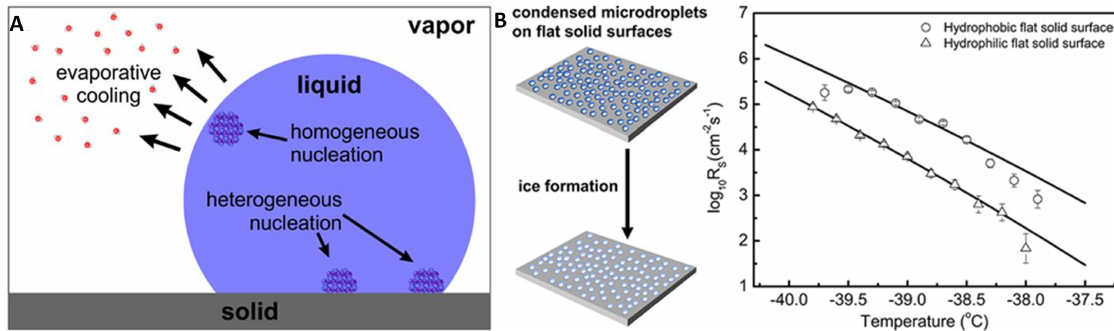
Figure 2. ( A ) Illustrates regions on a water droplet where homogeneous and heterogeneous ice nucleation occur and the influence of outside factors such as evaporation; ( B ) Shows the normalized surface ice nucleation rate for water microdprolets on flat, solid, hydrophobic and hydrophilic surfaces. Reprinted with permission from Refs. [32,130], respectively. c (cid:13) 2014 and c (cid:13) 2012 American Chemical